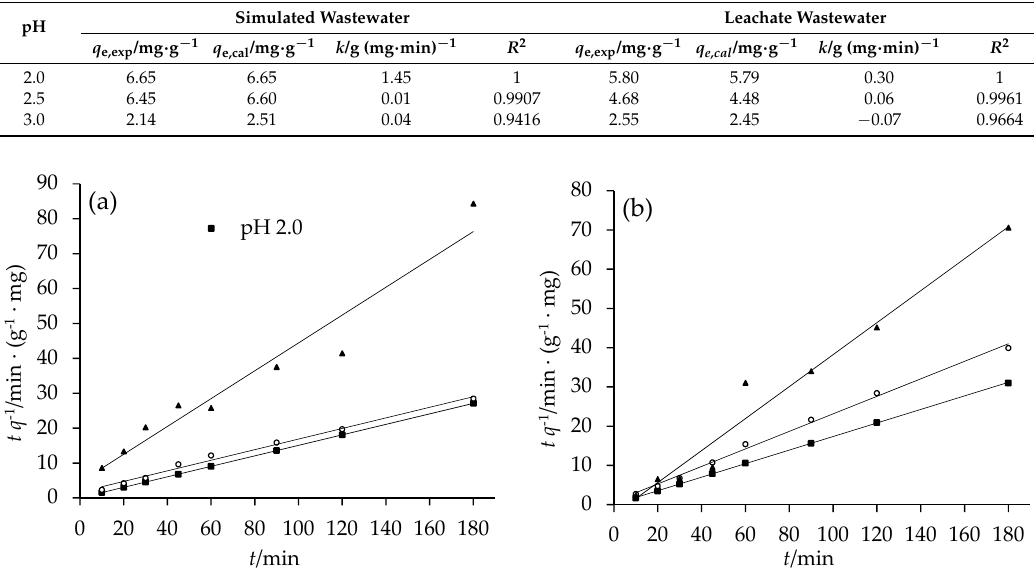
Figure 6. Pseudo second-order model for Cr(VI) removal by BFe 0 NPs (4%) at different pH values: ( a ) simulated wastewater; and ( b ) leachate wastewater.